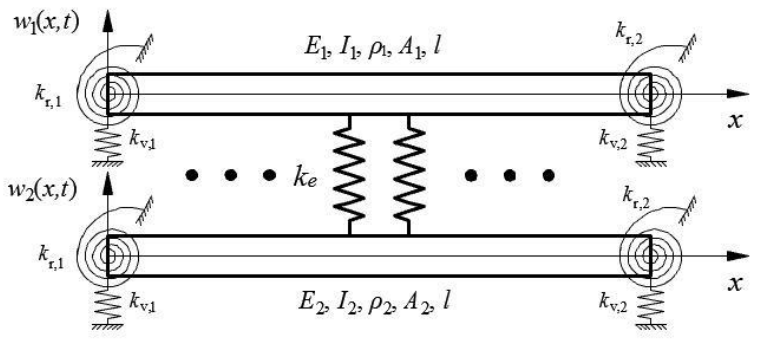
Figure 1. Double-beam system with symmetric boundary conditions.